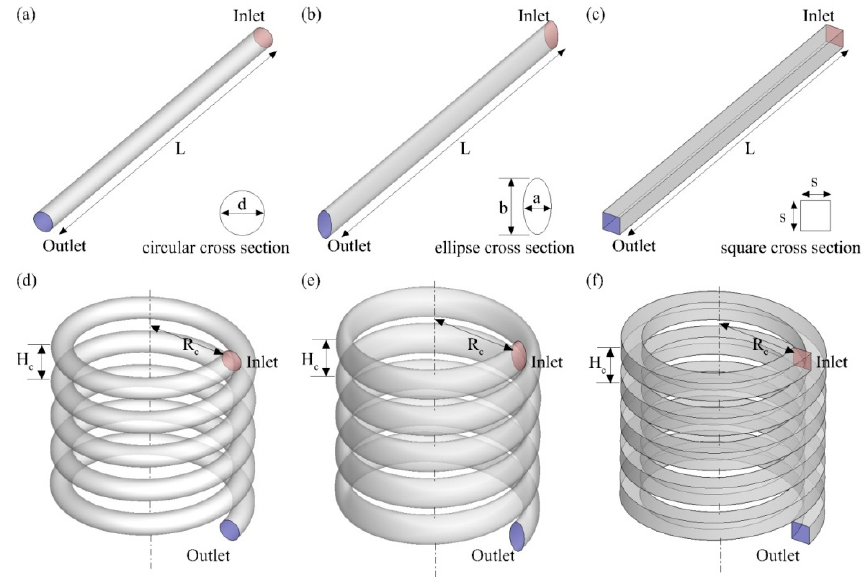
Figure 1. Schematics of the investigated cooling channel.